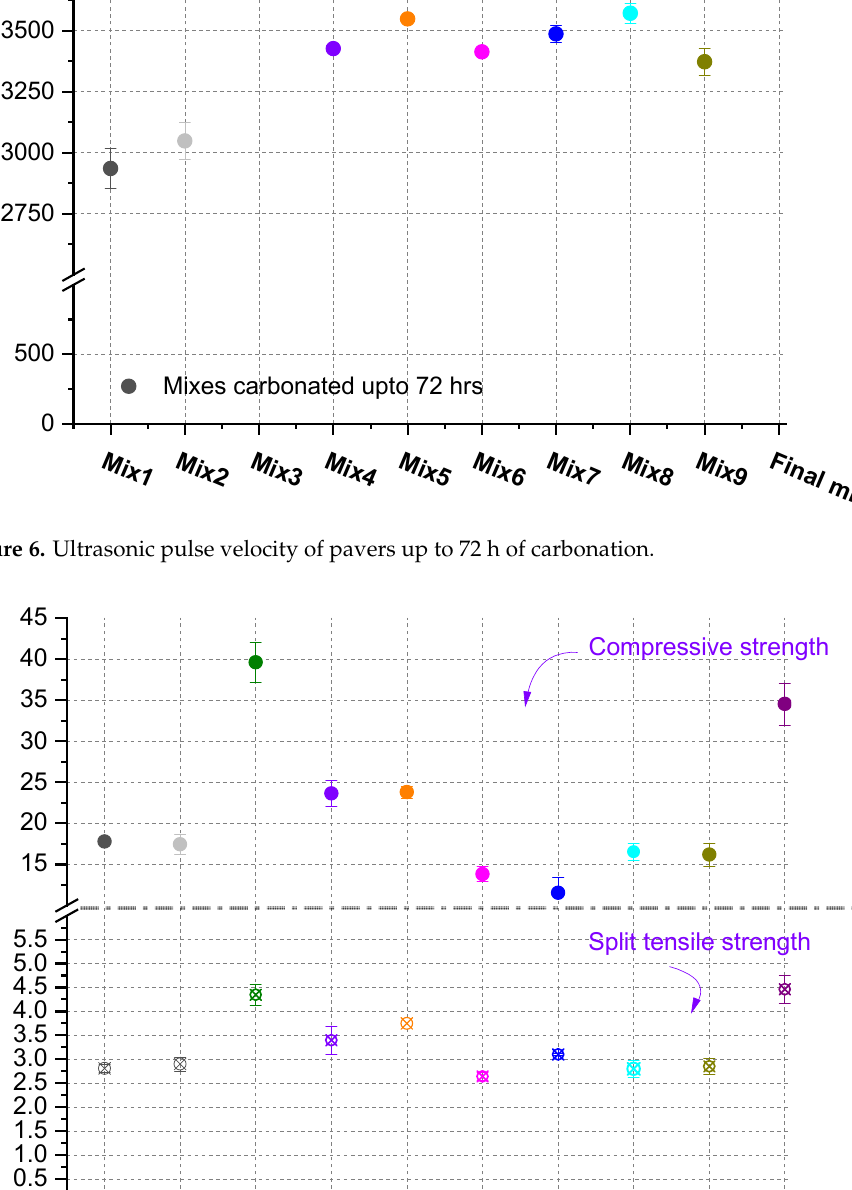
Figure 8. Ratio of splitting tensile to compressive strength versus paver’s compressive strength.